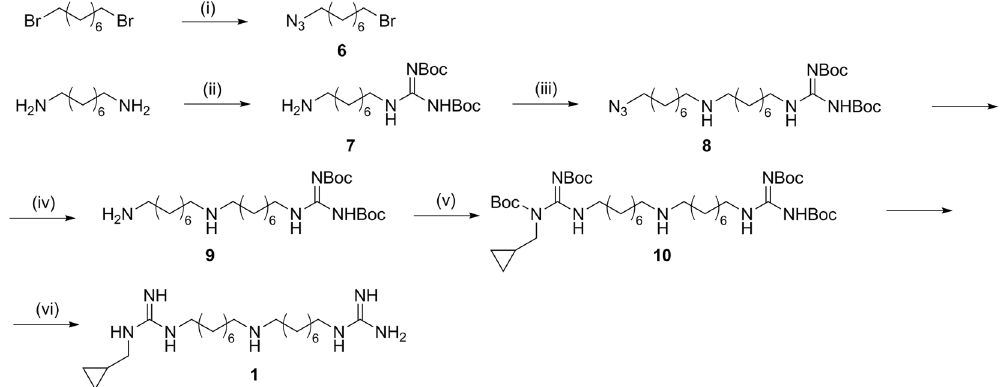
Figure 5. Synthesis of monomer ( 1 ). Reagents and conditions: (i) NaN 3 , DMF, 50 °C, 16 h; (ii) 1,3-Bis(tert- butoxycarbonyl)-2-methyl-2-thiopseudourea, DIPEA, CH carboxamidine, DIPEA, THF, 16 h, r.t.; (vi) TFA 10%, dry DCM, r.t., 7